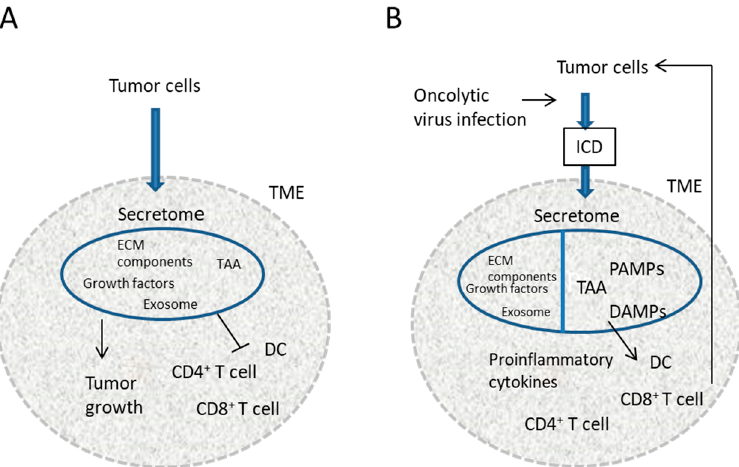
Figure 1. A model of the augmentation of antitumor immunity by an oncolytic virus. ( A ) Immunological abnormalities associated with TME inhibit the priming of antitumor adaptive immunity or tolerize tumor-specific CD4 + and CD8 + T cells; ( B ) Oncolytic viruses induce ICD with the release of secretomes containing DAMPs, PAMPs, proinflammatory cytokines, and TAA. This triggers DC maturation and cytotoxic CD8 + T cell proliferation. The reduced secretion of stromal components due to viral infection also overcomes TME-associated immunosuppression. TME, tumor microenvironment; ECM, extracellular matrix; TAA, tumor-associated antigen; ICD, immunogenic cell death; DC, dendritic cell; PAMPs, pathogen-associated molecular patterns; DAMPs, damage-associated molecular patterns.